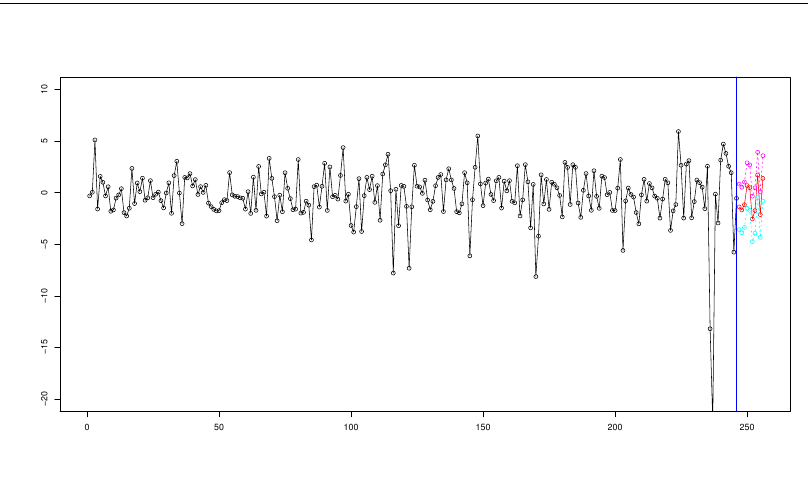
Figure 7 – Plot of the predicted values of BPCL